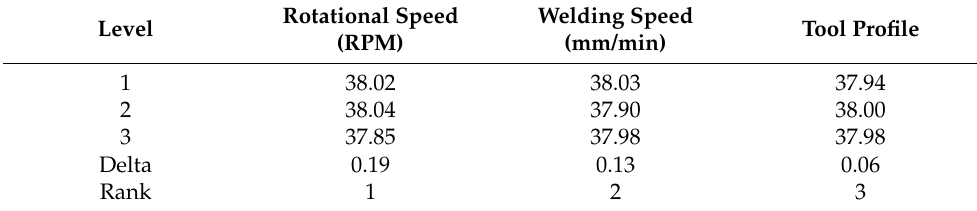
Table 7. Response table for the S/N ratio for hardness in the